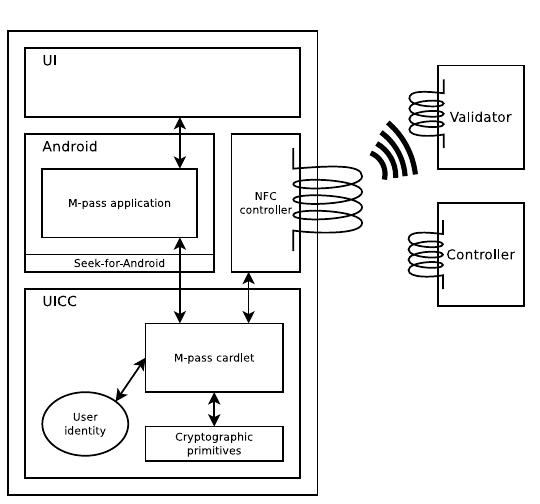
Figure 1. Overview of an m-pass